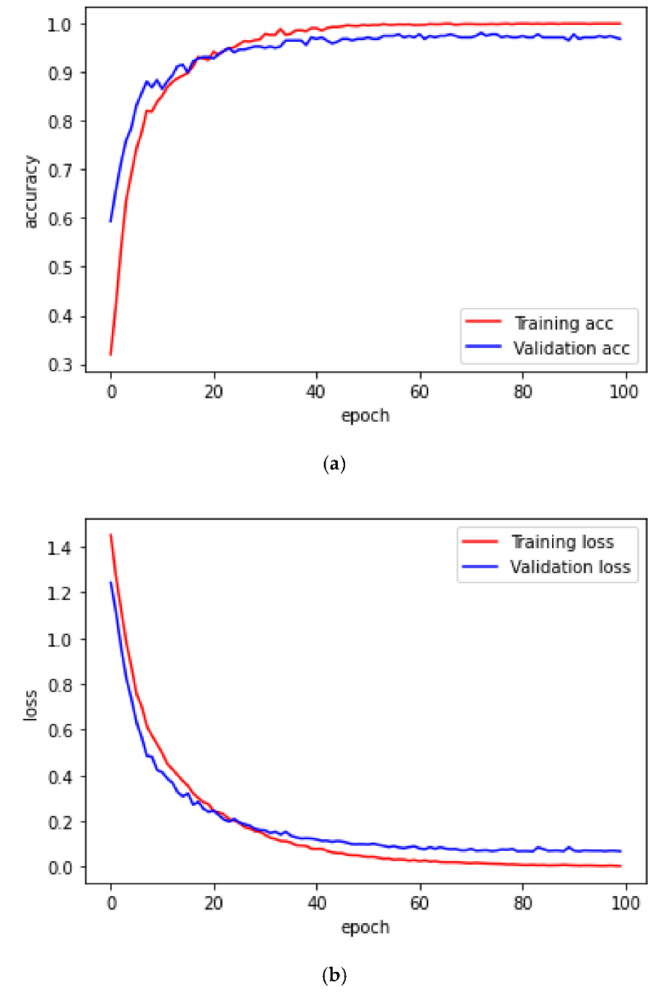
Figure 9. ( a ) Training/validation accuracy and ( b ) loss trend with each epoch.